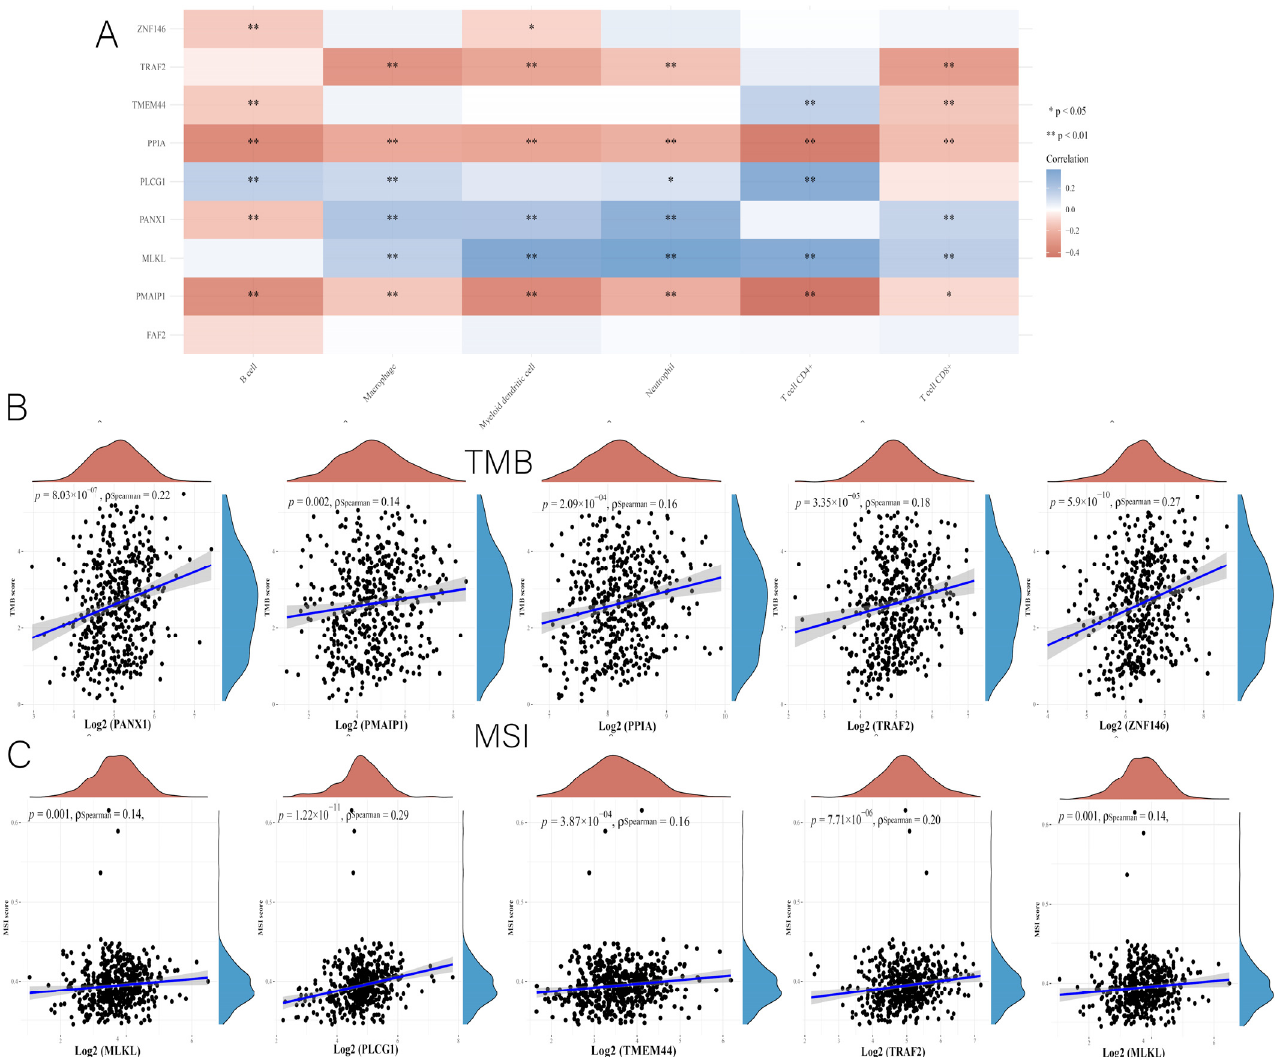
Figure 12. ( A ) Correlation of DENRGs with immune cells in the prognostic model. ( B ) DENRGs associated with TMB in the prognostic model. ( C ) DENRGs associated with MSI in the prognostic model. * p < 0.05, ** p < 0.01.